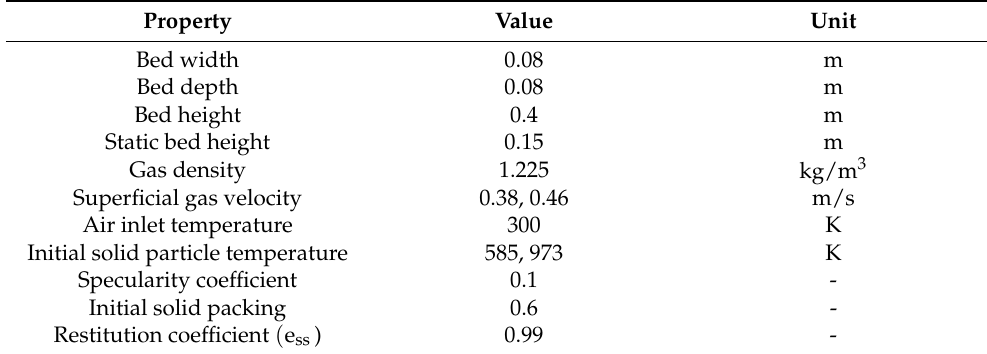
Table 1. Physical properties and operating parameters utilized in the model. Property